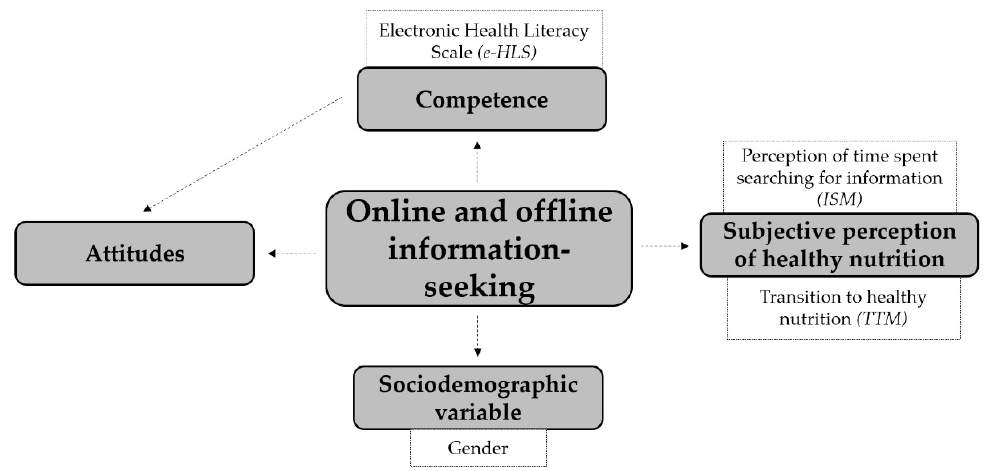
Figure 2. Preliminary interrelatedness of the theoretical concept.